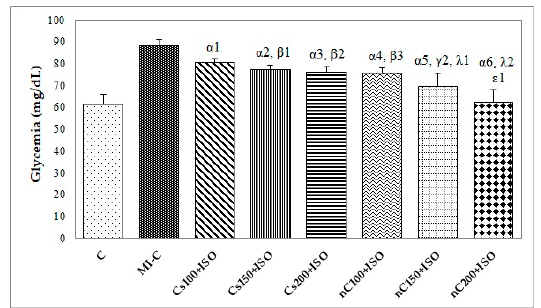
Figure 6. Serum levels of glycemia by groups. C = control; MI-C = isoproterenol without any pre-treatment; Cs = curcumin solution, in doses of 100 mg / kg bw (Cs100), 150 mg / kg bw (Cs150), and 200 mg / kg bw (Cs200); nC = curcumin nanoparticle solution, in doses of 100 mg / kg bw (nC100), 150 mg / kg bw (nC150), and 200 mg / kg bw (nC200). The letter-number codes correspond to the p